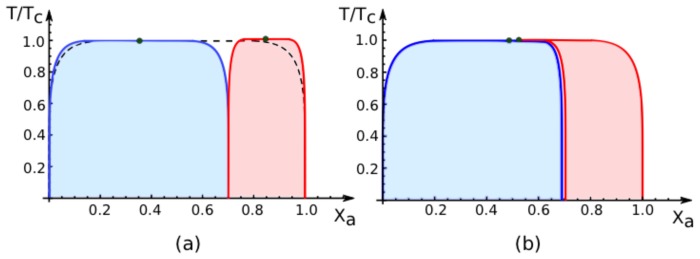
Exact phase diagrams of the lattice model for adhering membranes as a function of mole fraction Xa and reduced temperature T/Tc for (a) large and (b) small positive values of the affinity contrast ΔU2,1 = ΔU[2] − ΔU[1] and fixed area fraction q[1] = 0.7 of membrane segment
S[1]. The blue and red regions represent the two-phase coexistence regions of segment
S[1] and
S[2], respectively. Likewise, the blue and red curves correspond to the binodal lines for these two segments. Positive values of ΔU2,1 imply that the a-molecules prefer to stay in segment
S[1] corresponding to the unbound segments in Figure 2 and Figure 3a as well as to the weakly bound segment in Figure 3b. Therefore, as one increases the mole fraction Xa starting from Xa = 0, one first enters the blue coexistence region for segment
S[1] and subsequently the red coexistence region for segment
S[2]. The two critical points depicted in (b) merge in the limit of vanishing affinity contrast, ΔU2,1 = 0. The broken line in (a) represents the binodals for the coexistence region of the uni-env membrane, i.e., for the same two-component membrane in a uniform environment; in (b), the broken line is masked by the blue and red binodals. For T > 0, the blue and red coexistence regions in (a) and (b) are separated by an intermediate one-phase region, in which the adhering membrane does not undergo phase separation even though the uni-env membrane does.